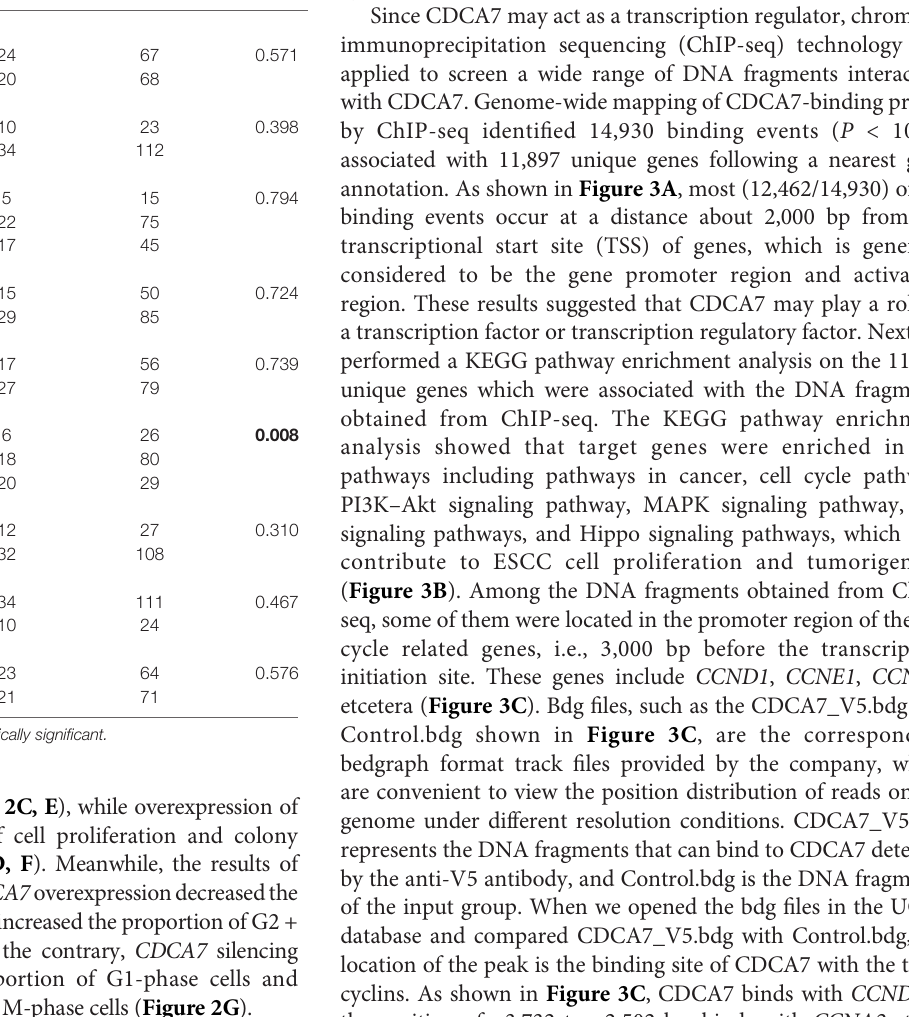
TABLE 1 | Correlation analysis between CDCA7 copy number in ESCC and clinicopathological variables. Clinical